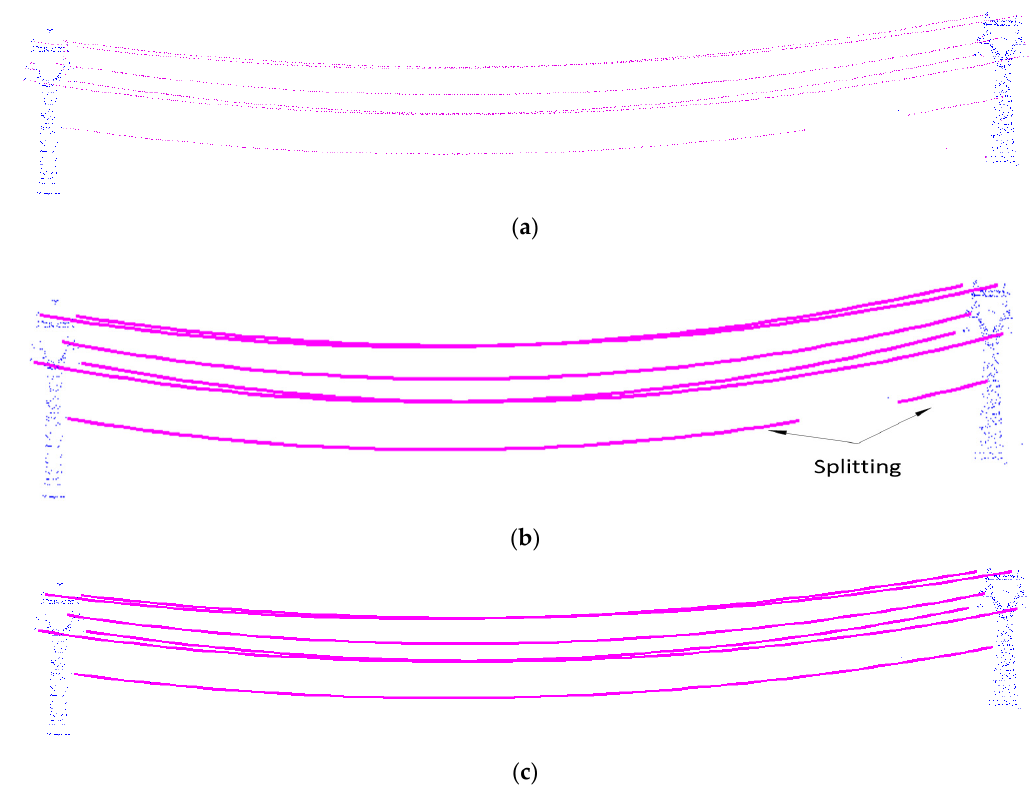
Figure 11. ( a ) Original data; ( b ) reconstruction results using McLaughlin’s method [9]; and ( c ) reconstruction results with our method.